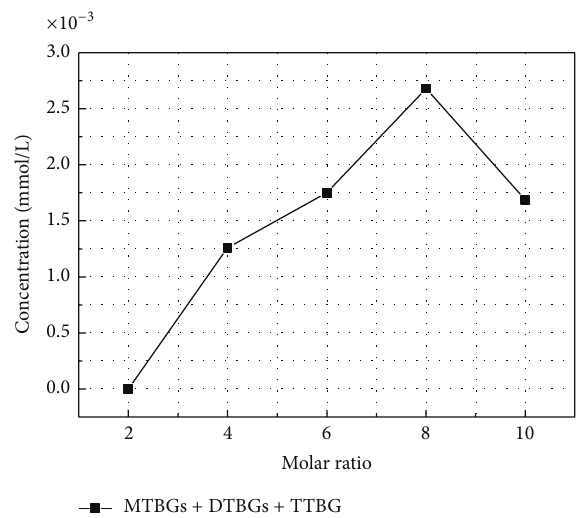
Figure 7: Influence of temperature on glycerol conversion. Reaction conditions: Amberlyst 15 catalyst = 7.5 wt.% to glycerol, molar ratio = 4 :1, and 8